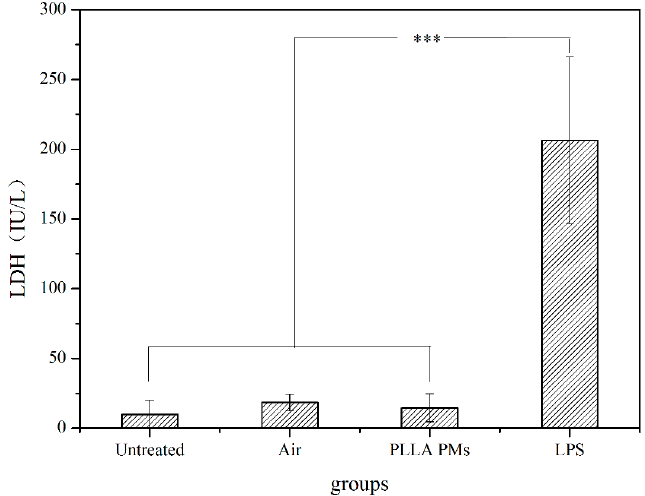
Figure 9. LDH levels of different treatments. *** P < 0.01.